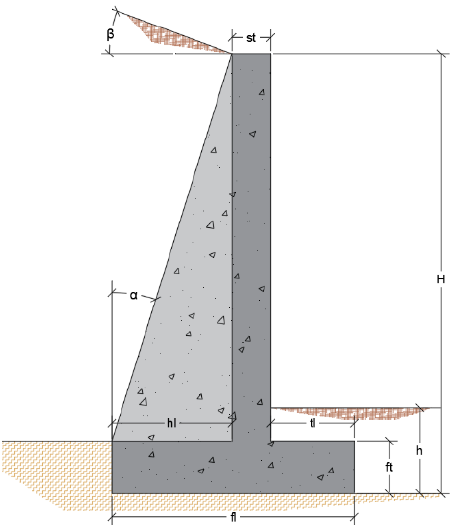
Figure 1. Geometrical variables of the buttressed wall.